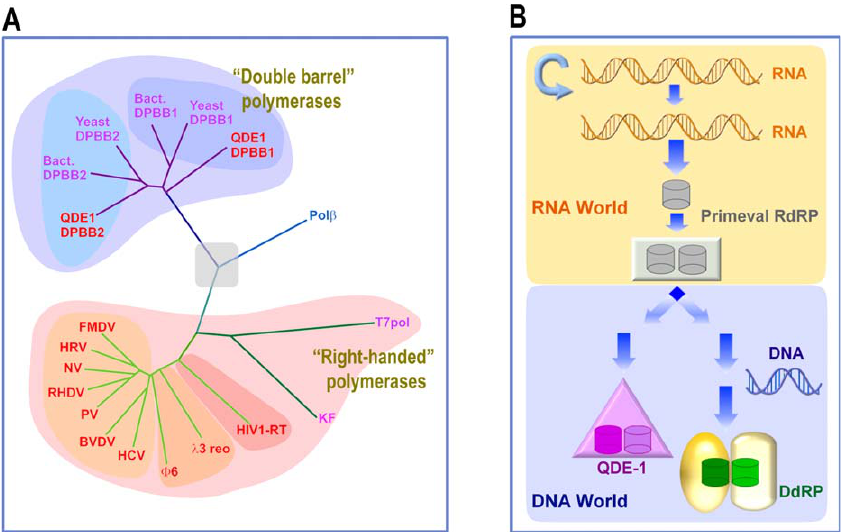
Figure 5. Evolutionary Relationships (A) Evolutionary phylogenetic tree for known polymerases based on structural similarity (for description of the method see [43]). The ‘‘ right-handed ’’ polymerases, ‘‘ double-barrel ’’ polymerases, and pol b appear to form three separate, unrelated families. Within the ‘‘ double-barrel ’’ family, the DPBB2 domains containing the active site aspartate residues are more structurally conserved than DPBB1. Branches are coloured according to structural fold: green, right hand (dark, cellular; and light, viral), Pol b , blue; and DPBB-containing fold, dark magenta. Since we do not believe that all polymerases originate from a common ancestor, the central node of the tree is shaded grey. The key to the additional structures is: Yeast DPBB1, yeast RNApolII DPBB from Rbp2; Yeast DPBB2, yeast RNApolII DPBB from Rbp1; Bact. DPBB1, bacterial b subunit DPBB; Bact. DPBB2, bacterial b 9 subunit DPBB; Pol b , rat DNA polymerase b ; T7pol, bacteriophage T7 DdRP; KF, Klenow fragment of DNA polymerase I; HIV1-RT, human immunodeficiency virus type 1 (HIV-1) reverse transcriptase (RT); k 3 reo, reovirus RdRP; U 6, U 6 bacteriophage RdRP; HCV, hepatitis C virus RdRP; BVDV, bovine viral diarrhoea virus RdRP; PV, poliovirus RdRP; RHDV, rabbit hemorrhagic disease virus RdRP; NV, Norwalk virus RdRP; HRV, human rhinovirus RdRP; and FMDV, foot–and-mouth disease virus RdRP. (B) Originally, in an all RNA world, RNA self-replicates until the advent of a protein-based, primeval RNA-dependent RNA polymerase. Initially this possesses a single DPBB domain on a single polypeptide chain. Gene duplication leads to a polypeptide chain containing two copies of the DPBB domain. Differentiation of the two DPBB domains then results in QDE-1–like RdRPs. Emergence of DNA and associated increase of complexity lead to segregation of the DPBB into different polypeptidic chains, giving rise to the complex multi-subunit DdRP machinery observed